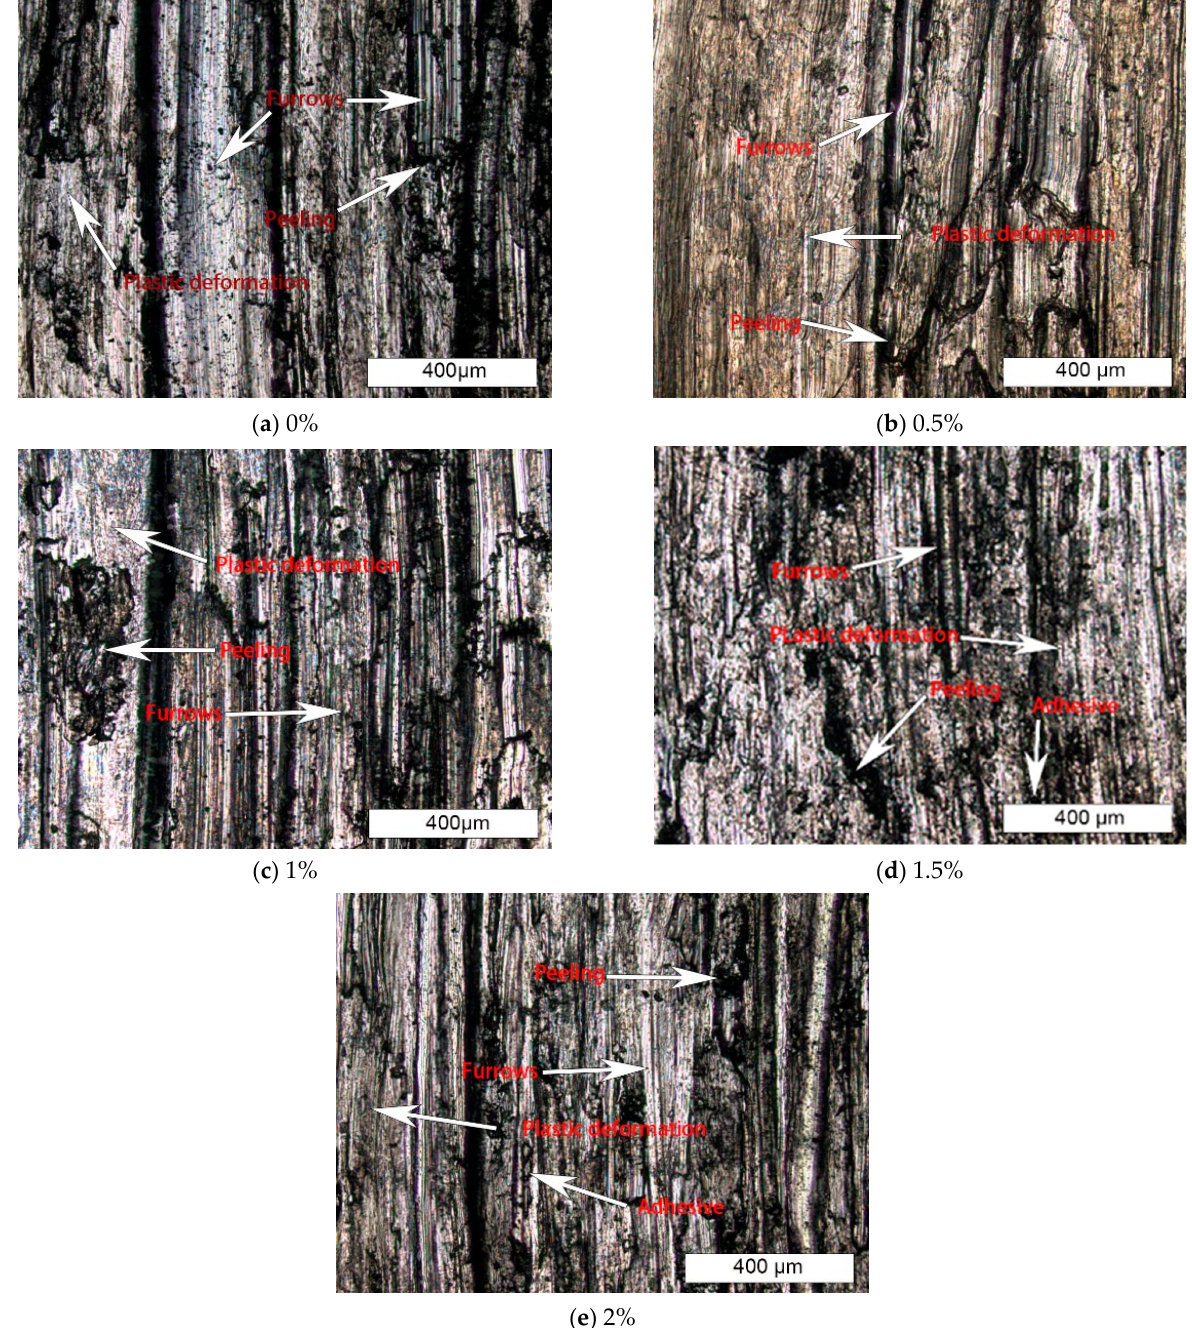
Figure 12. Wear morphology of surfacing layers with different amounts of boron.